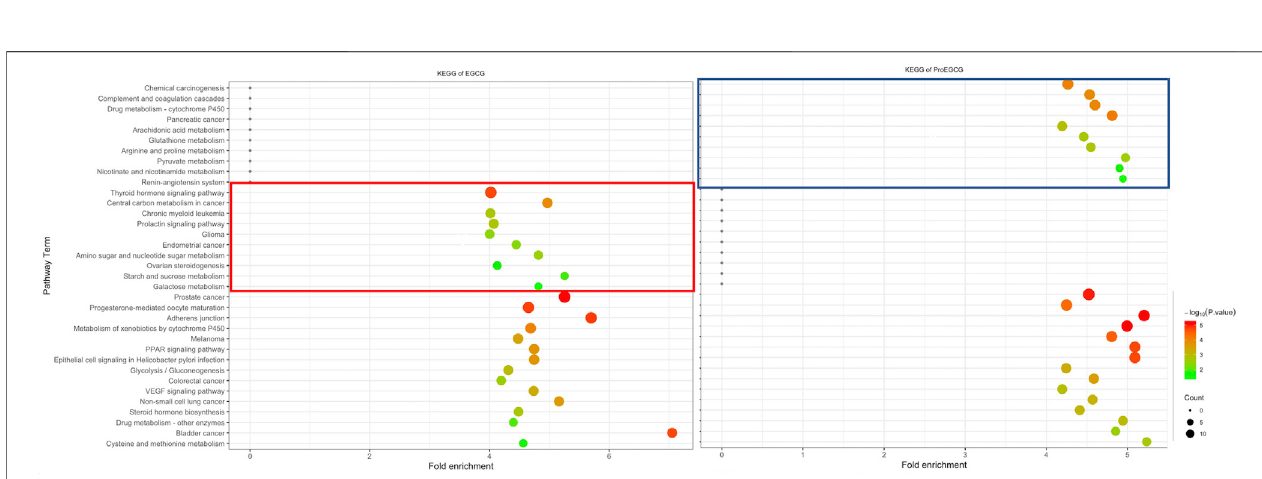
FIGURE 3 | Differentia KEGG pathway ofEGCG (left) and ProEGCG (right) . Differential pathways ofEGCG and ProEGCG were highlighted in red (EGCG) or blue (ProEGCG).